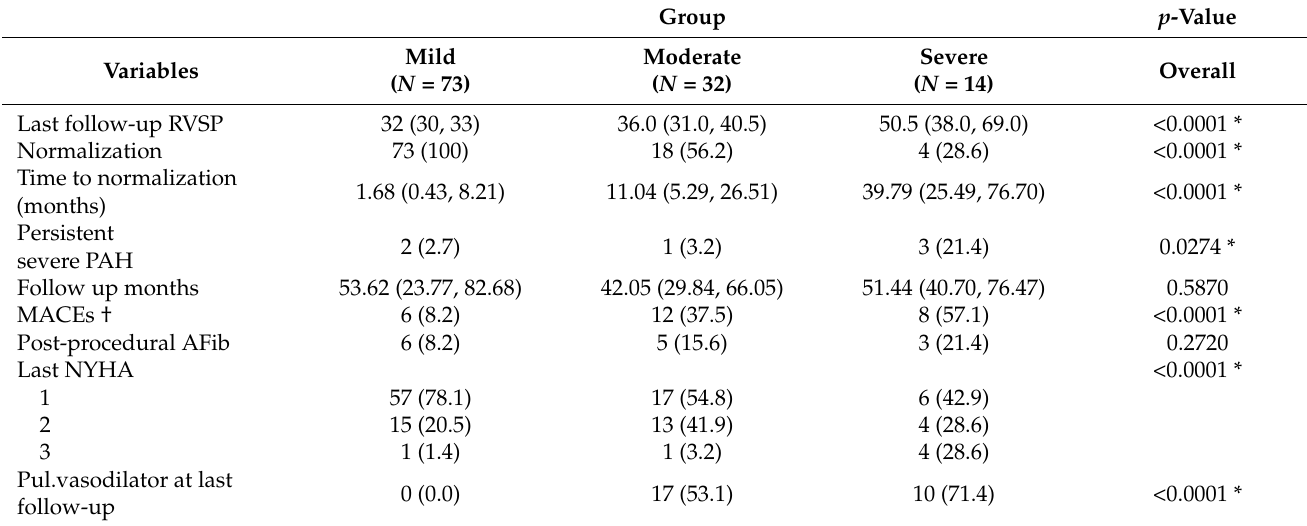
Table 2. Hemodynamic and clinical outcomes